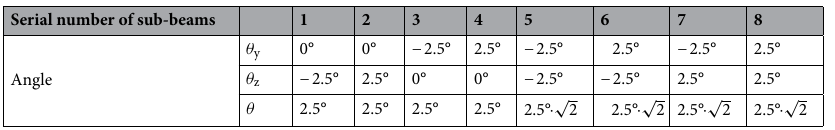
+ θ 2 θ 2 y z . (cid:31)